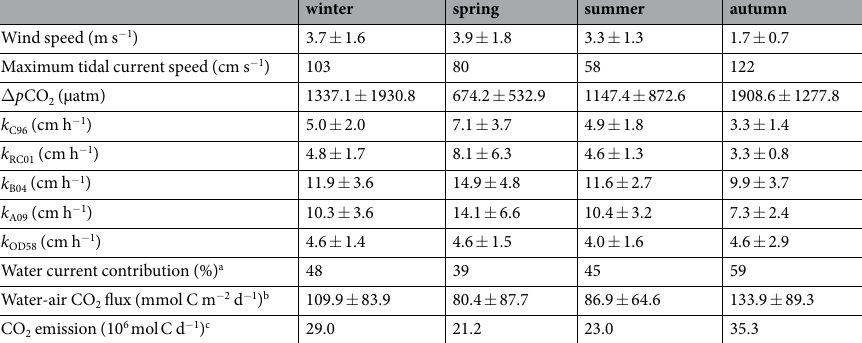
Table 2. Tagus estuary seasonal values for daily average wind speed, maximum tidal current speed, p CO 2 gradient ( Δ p CO 2 ), CO 2 gas transfer velocity ( k ) given by the parameterizations of Carini et al . 42 ( k C96 ), Raymond and Cole 43 ( k RC01 ), Abril et al . 8 ( k RC01 ), Borges et al . 7 ( k B04 ) and O ’ Connor and Dobbins 9 ( k OD58 ), water current contribution, water-air CO 2 fluxes and CO 2 emission. a calculated as the ratio k OD58 /( k OD58 + k C96 ) b averaged